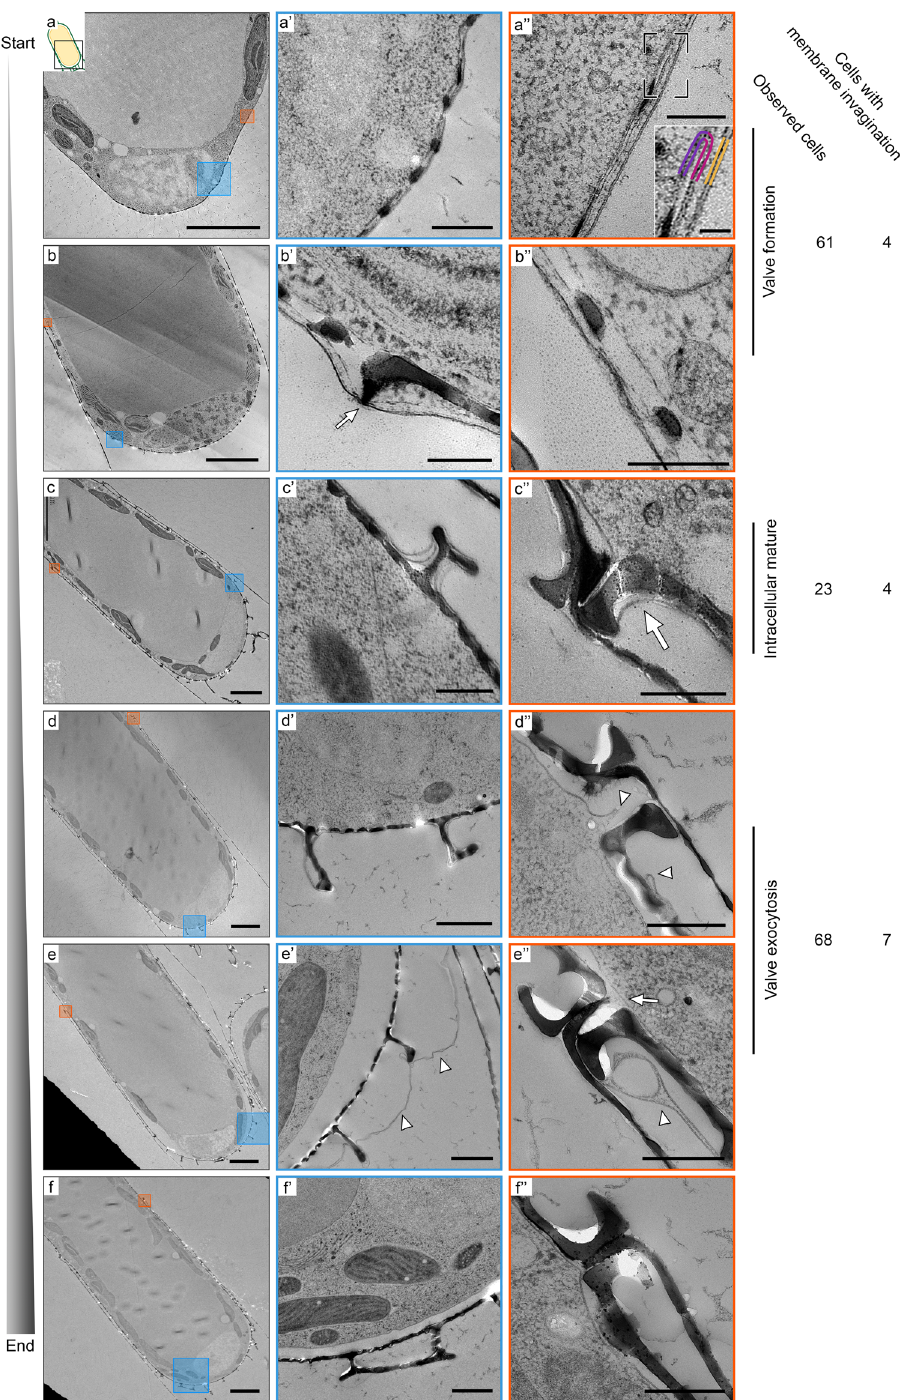
Fig. 3 | TEM images showing sequential stages of valve formation and exocy- tosis in S. turris . Left column shows a representative image of each stage, with higher magni fi cation views of the boxed areas in the right columns. a Valve for- mation starts at the apex of the cell. a ’ Growingsilica inside the SDV thatislocated directly under the plasma membrane. a ” The SDV ends at the growing silica edge. The inset shows the bilayersof the proximal(purple) and distal(pink) SDV and the plasmamembrane(yellow)inhighermagni fi cation. b Laterduringvalveformation, b ’ thepolygonallayer(arrow)isformedontopofthebaselayer,and b ” thegrowing edge of the new valve reaches the rim of the parental valve. c Silici fi cation of the new valve is completed while it is still fully enclosed in the SDV. Mature valves can be recognized by: c ’ the fully formed and fl attened polygonal layer, and c ”